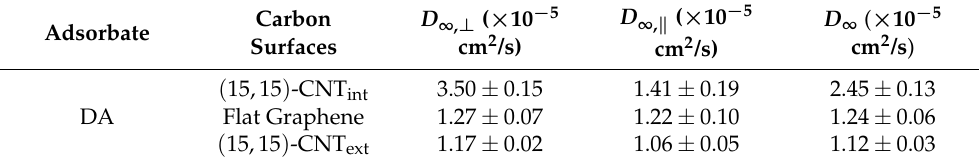
Table 1. Diffusion coefficients extrapolated to the infinite system sizes. For a subset of the carbon surfaces, diffusion constants for the infinite system sizes, D ∞ , were extrapolated from a series of differently sized finite simulations. The extrapolation was done to correct for unphysical effects that arise from the necessarily finite simulation sizes, and the D ∞ values thus represent the actual diffusivities expected within the larger physical systems. See SI and Figure S4 for details.